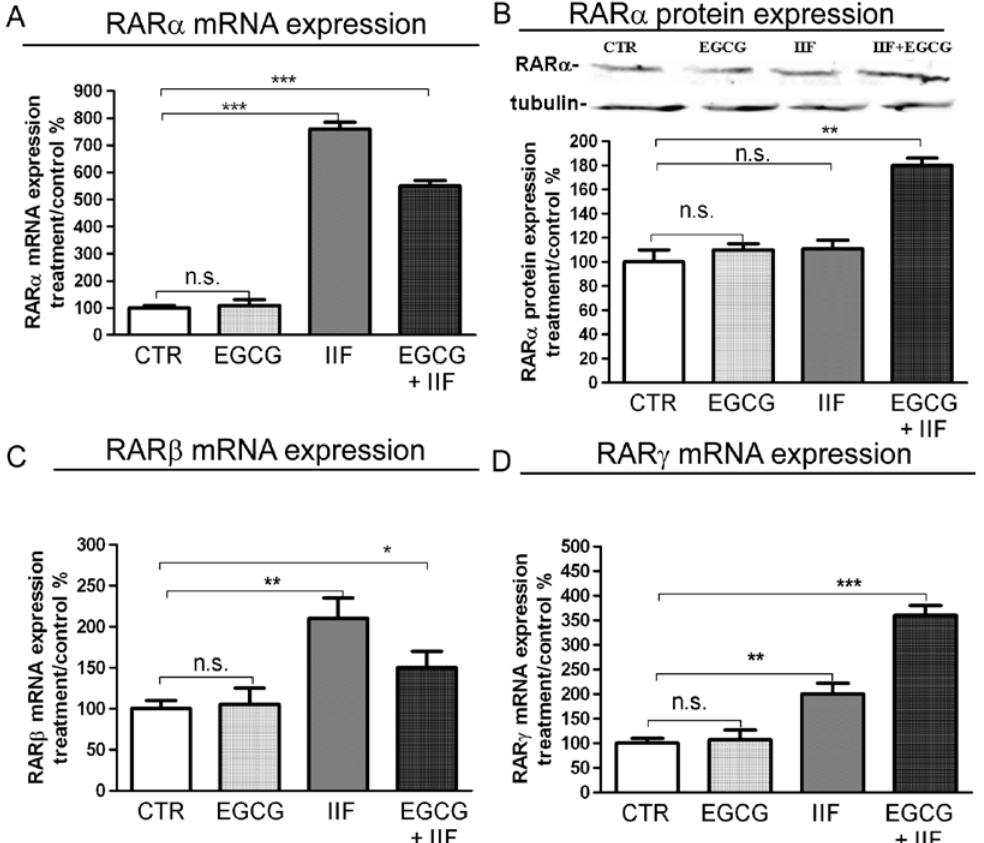
Figure 1. RAR α β and γ mRNA expression and RAR α protein expression in BE(2)-C neuroblastoma cells. Cells were treated with 20 µ g/mL epigallocatechin-3-gallate (EGCG) and 10 µ M 6-OH-11-O-hydroxyphenanthrene (IIF), individually and in combination for 24 h. ( A , C , D ) RAR α β and γ mRNA expression as detected by qPCR in control (CTR) and treated samples. ( B ) RAR α protein expression. Proteins (50 µ g) from total cell lysates were subjected to Sodium Dodecyl Sulphate-PolyAcrylamide Gel Electrophoresis SDS–PAGE and Western blot analysis. The values were normalized to the untreated controls. β -tubulin was used as a loading control. The results are expressed as the average ± standard errors (SE) of three independent experiments. * p < 0.05; ** p < 0.01; *** p < 0.001. n.s.: not significant.